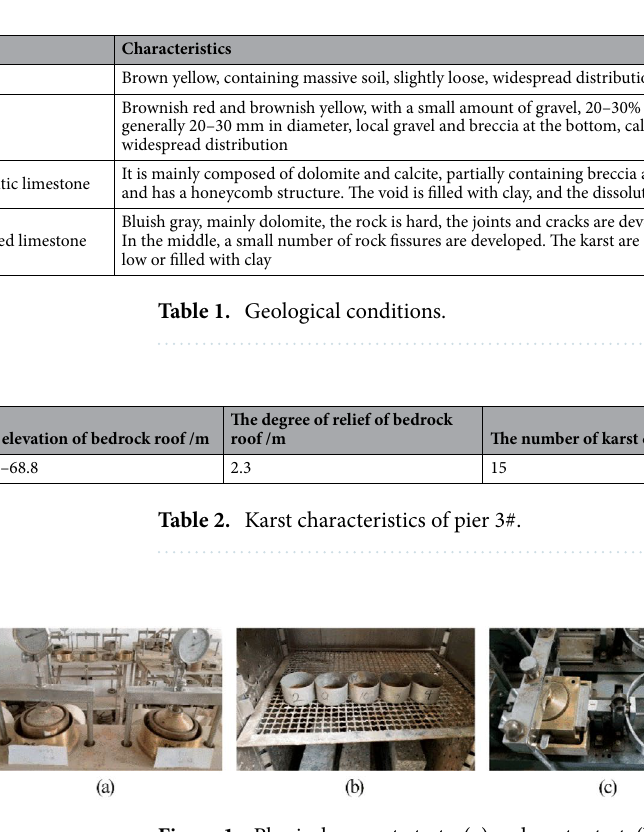
Figure 1. Physical property tests: ( a ) oedometer test; ( b ) moisture content test; ( c ) direct shear test; ( d ) specimens with different proportions; ( e ) compression tests.